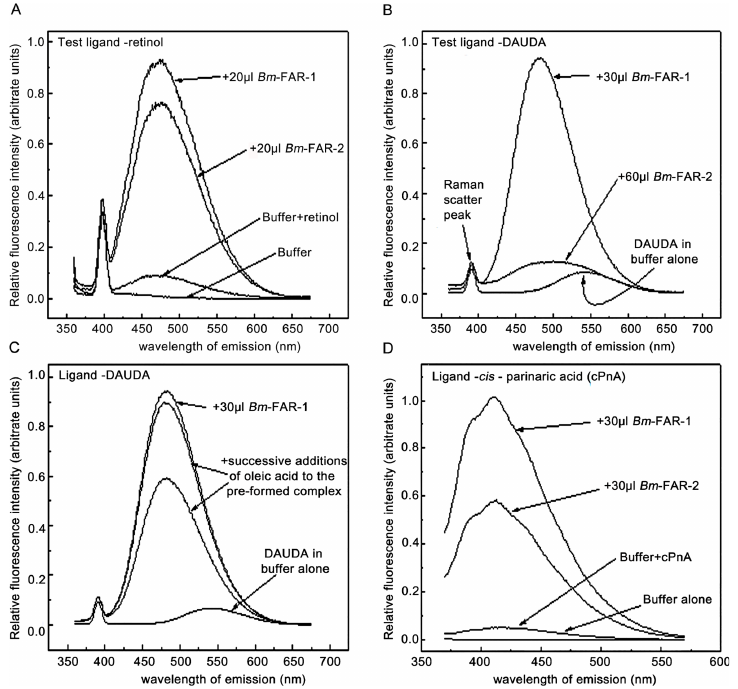
Fig 5. Lipid binding properties of r Bm- FAR-1 and r Bm- FAR-2. Fluorescence emission spectra were recorded, and spectrofluorimetry conditions set, as described in Materials and Methods. (A) Retinol in ethanol was added to 2 ml PBS, pH 7.2 (to create an approximately 4 μ M solution of retinol) alone, or 2 ml PBS containing r Bm- FAR-1 or r Bm- FAR-2. Both proteins clearly bind retinol. ( B) When rBm- FAR-1 and r Bm- FAR-2 were added to 2 ml of an approximately 1 μ M solution of DAUDA in PBS, Bm- FAR-1 elicited a dramatic increase and blue shift in DAUDA fluorescence emission, whereas Bm- FAR-2 did so to a minimal extent. ( C) Addition of oleic acid to pre-formed Bm- FAR-1:DAUDA complexes results in competitive displacement of DAUDA from the protein binding site, indicating that there exists a binding site with preference for natural fatty acids. ( D) Both proteins bind cis -parinaric acid (cPnA), albeit yielding different amplitudes of change in cPnA emission, but this nevertheless indicates that both proteins bind fatty acids. Similar experiments were carried out with the orthologues of these proteins from the river blindness parasite O . volvulus (r Ov -FAR-1 and r Ov -FAR-2) and the results were directly comparable to results with the Bm- FARs (see S2 Fig). worm numbers (68.4%, p = 0.0063) was observed only in the group of gerbils immunized with r Bm- FAR-1 formulated with Montanide-720 (Fig 7A). After immunization with 25 μg of r Bm- FAR-1 formulated with alum or Montanide-720 for three times, and following challenge with 100 infective B . malayi L3 in two separated experiments, a combined total worm reduction of 68.4% was observed with statistical significance ( p = 0.0063) in the group of gerbils immunized with r Bm- FAR-1 formulated with Montanide-720 compared to adjuvant control group (Fig 7A). The worm reductions for individual r Bm -FAR-1/Montanide-720 immunization were 68.0% ( p = 0.0139) and 44.4% ( p = 0.0541), respectively, compared to adjuvant control. Though a trend of reduction (38.5%) was observed with the alum formulation, it was not sta- tistically significantly different ( p = 0.1458) from its corresponding alum control (Fig 7A). The efficacy outcomes have been assembled from two experiments done in separate times. The dif- ferences in protection between the two vaccine formulation cannot be simply accounted for by the overall anti-IgG r Bm- FAR-1 antibody titers; the titers in both vaccinated groups after three immunizations and before challenge were similar (geometric mean of 4.81 x 10 5 and 5.15 x 10 5 , in alum or Montanide-720 formulated r Bm- FAR-1 vaccines, respectively) (Fig 7B). Under the same immunization regimen, gerbils immunized with r Bm- FAR-2 formulated with alum or Montanide-720 only produced 16% and 42% of adult worm reduction,